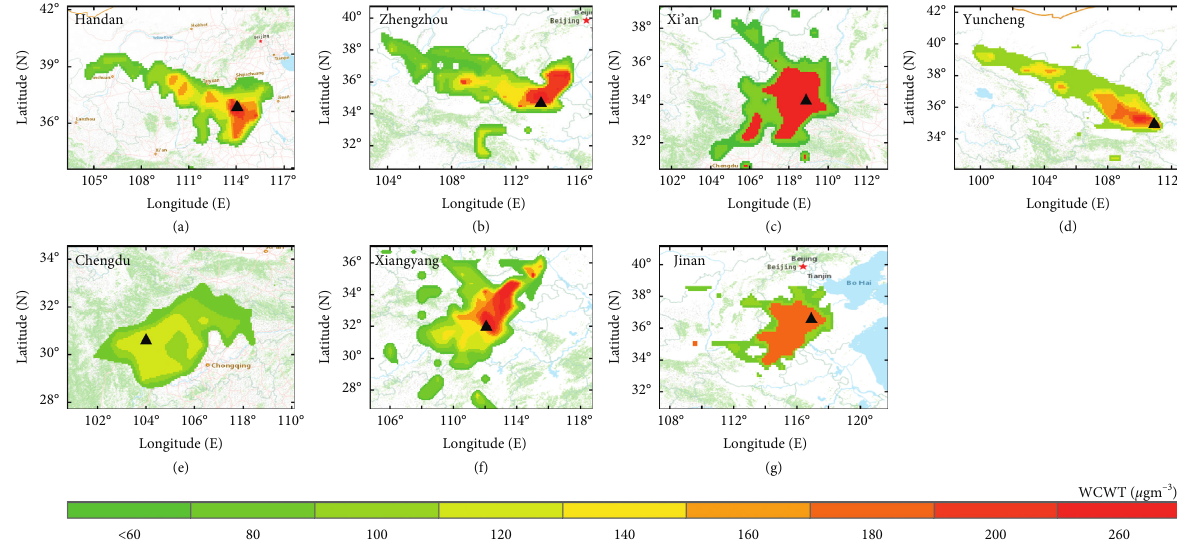
Figure 9: Potential sources of PM 2.5 by Concentration-Weighted Trajectory (CWT) in seven Chinese cities, with the large black triangles representing